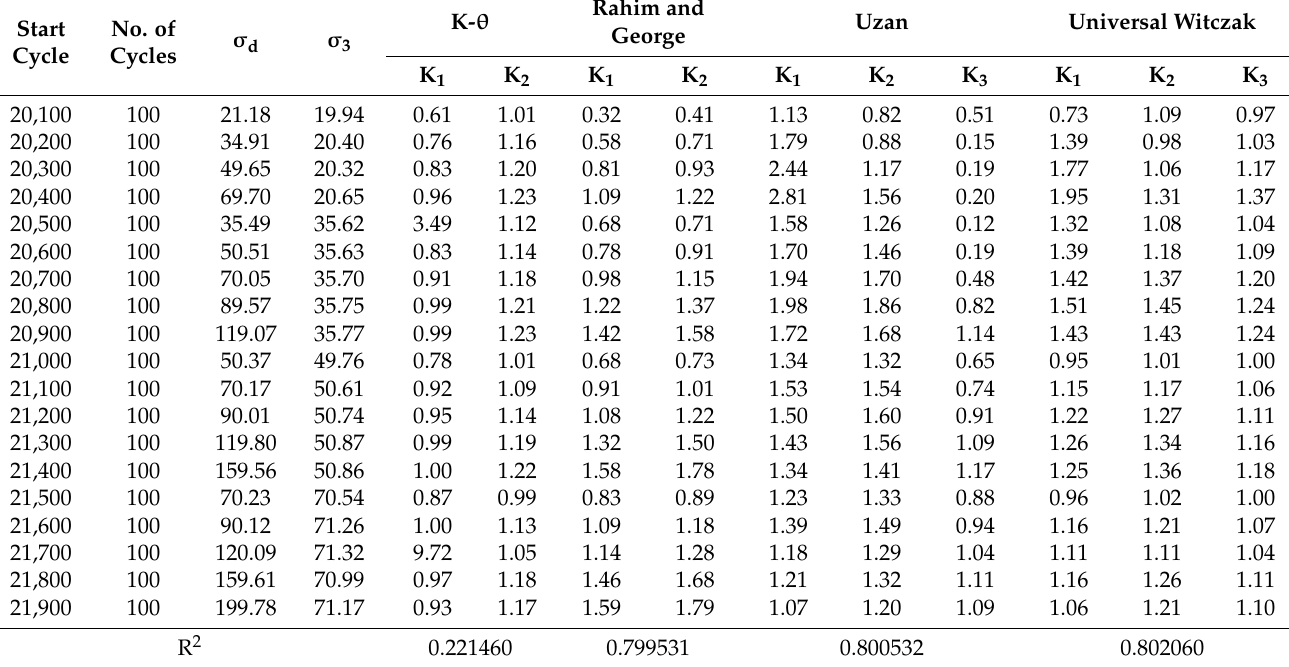
Table 7. Determination of models’ average regression coefficients for specimen